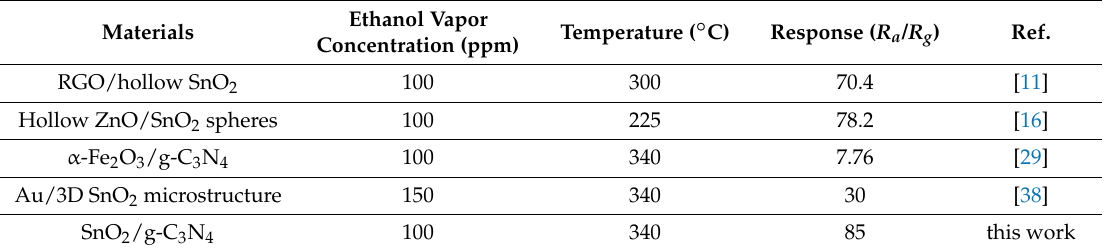
Table 1. The ethanol sensing performance of the previous reported results and this work.